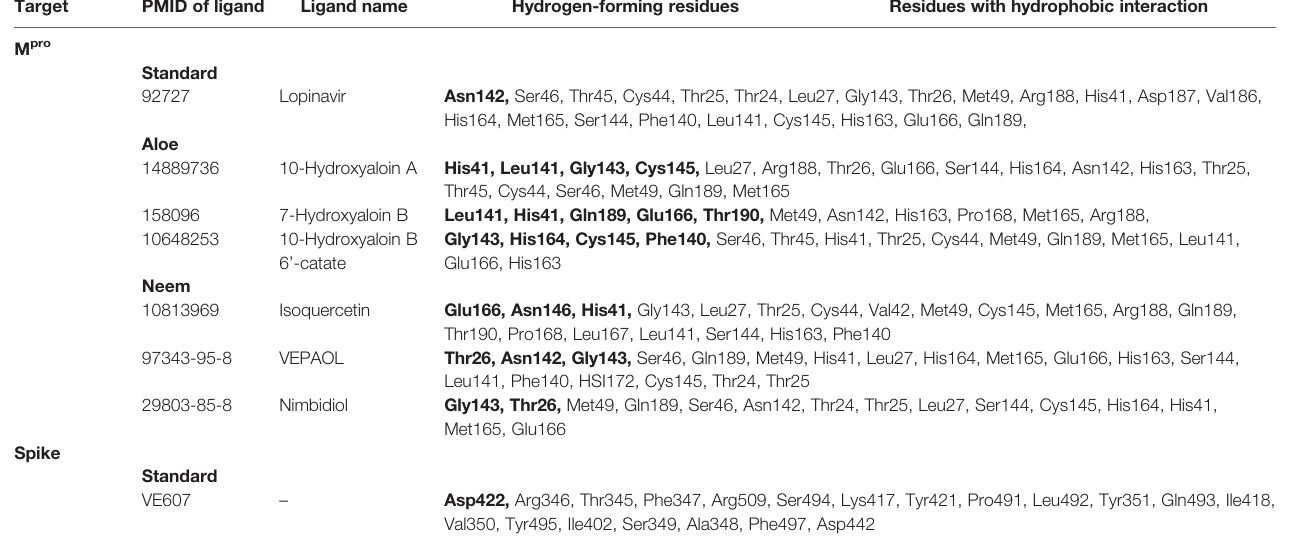
TABLE 3 | Docking score and type of interaction of standard inhibitor and top three Azadirachta indica and Aloe barbadensis phytochemicals against SARS-CoV-2 M pro , spike, and RdRp proteins. Target PMID of